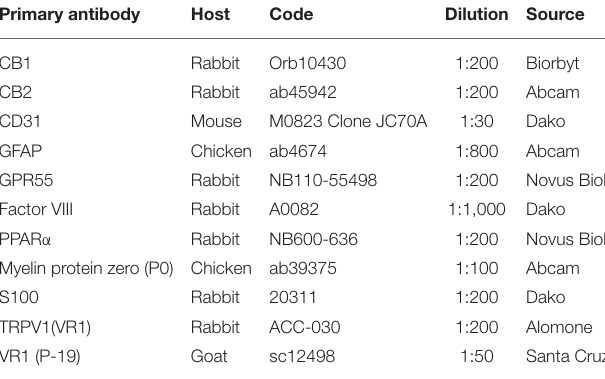
TABLE 2 | Primary antibodies used in the study.